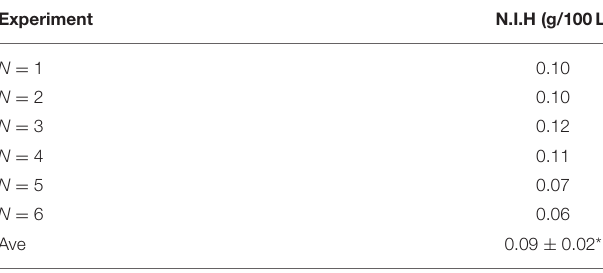
TABLE 3 | Normalized Index of Hemolysis (N.I.H) for bovine blood studies.